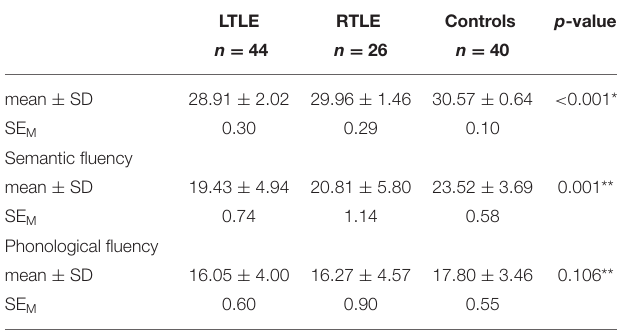
TABLE 1 | Sociodemographic, clinical, and neuropsychological characteristics of